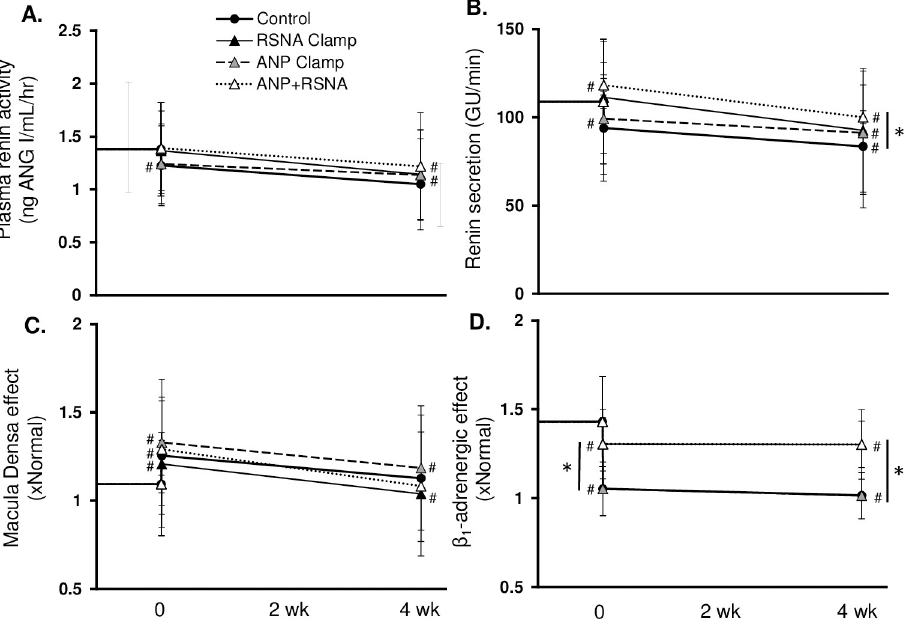
Fig 5. Renin secretion and its determinants before and during BAT in the control, RSNA Clamp, ANP Clamp, and ANP+RSNA Clamp simulations. � p < 0.05; #p < 0.05 vs. baseline.